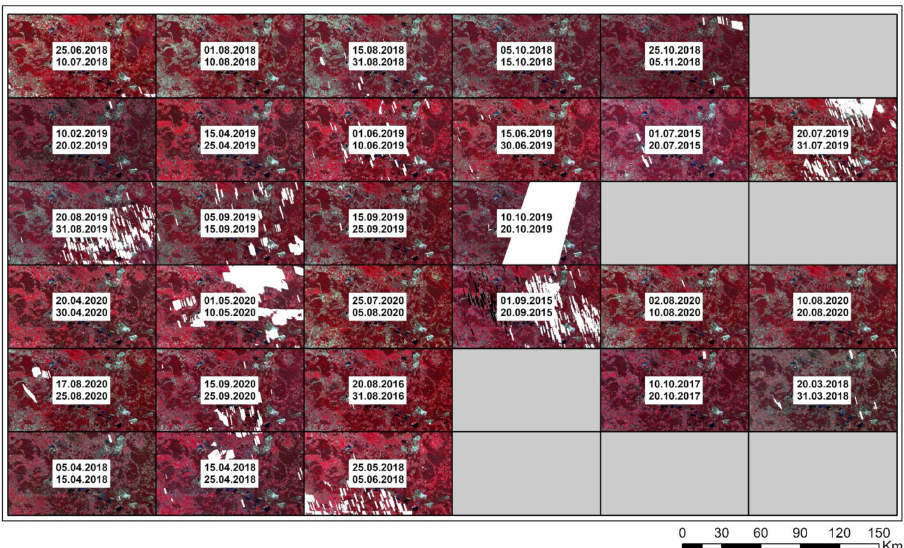
Figure 8. Single mosaic composed of 29 Sentinel-2 cloud- and shadow-free mosaics false-color images over the Lusatia region (bands 8-4-3).